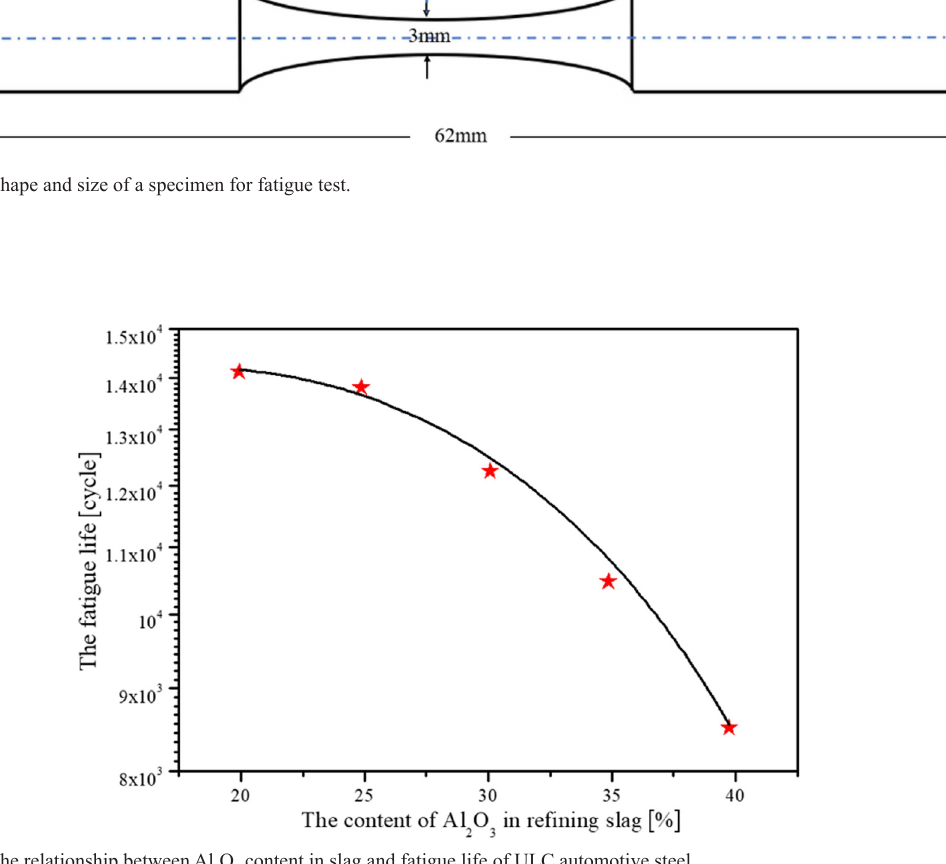
Figure 11. The relationship between Al